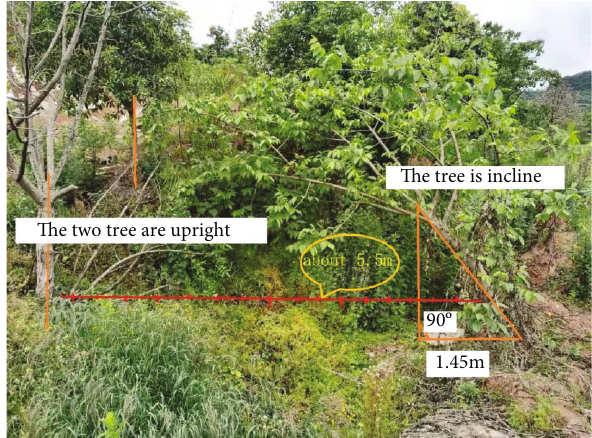
Figure 6: Vegetation indicating the occurrence of the secondary landslide. Trees on the left and right sides were approximately 4.2m apart. Vegetation on the right side was a ff ected by the secondary sliding body, and vegetation on the left side was a ff ected by the primary sliding body but not by the secondary sliding